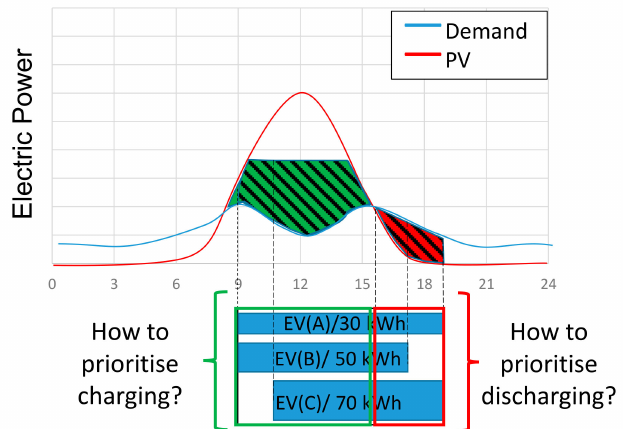
Figure 1. Graphical illustration showing the challenges of utilising electric vehicles as flexible resources in a workplace power system with high PV power generating